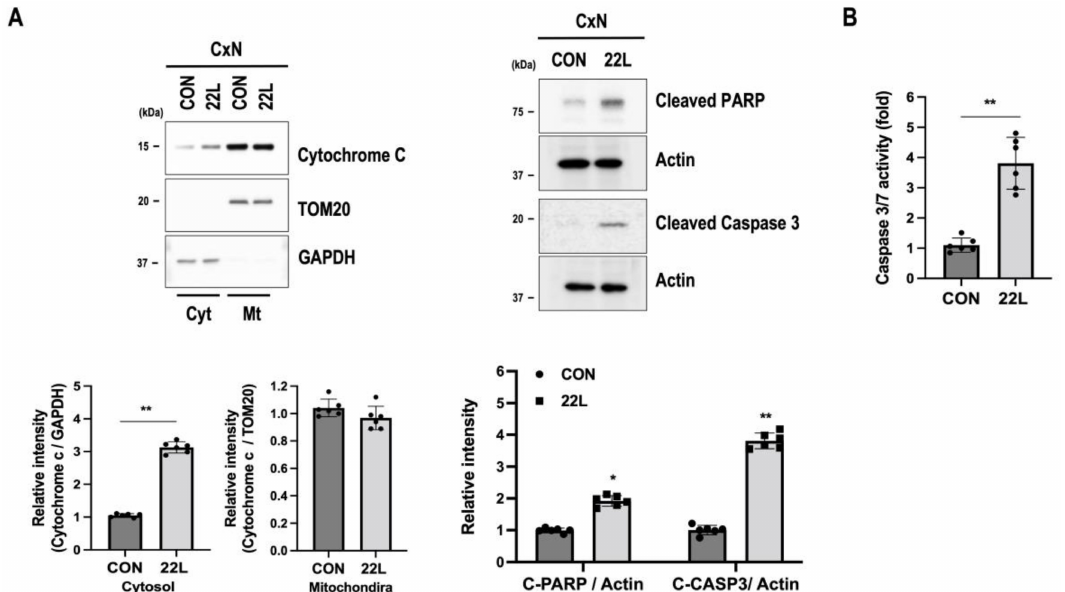
Figure 5. Scrapie infection induces cell apoptosis by promoting caspase 3 activation. ( A ) Expression levels of apoptosis-associated proteins (cytochrome c, cleaved PARP, and cleaved caspase-3) in control (CON) and 22L scrapie-infected (22L) CxN cells at 21 dpi were evaluated with Western blotting. The intensities of the bands were measured and quantified for each group ( n = 6, ** p < 0.01, * p < 0.05; two-sided Student’s t -test). ( B ) Caspase 3/7 activity was determined with a caspase 3/7 activity assay kit using a fluorescence reader ( n = 6, ** p < 0.01; two-sided Student’s t -test), n = number of independent experiments. C-PARP, cleaved PARP; C-CASP3, cleaved